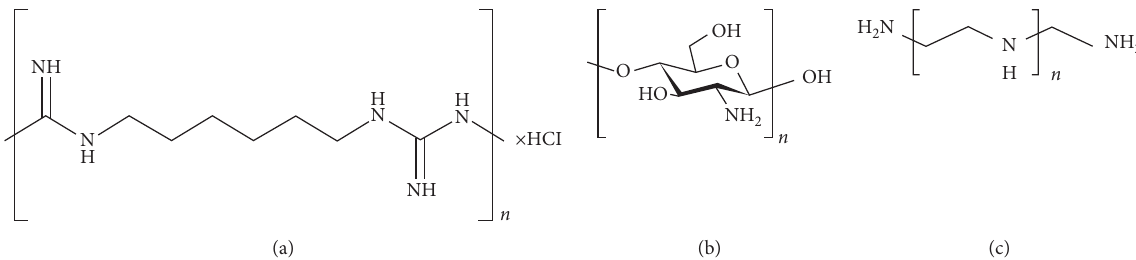
Figure 1: Chemical structure and functional groups of (a) polyhexamethylene biguanide hydrochloride (PHMB); (b) chitosan (CS), and (c) polyethylenimine